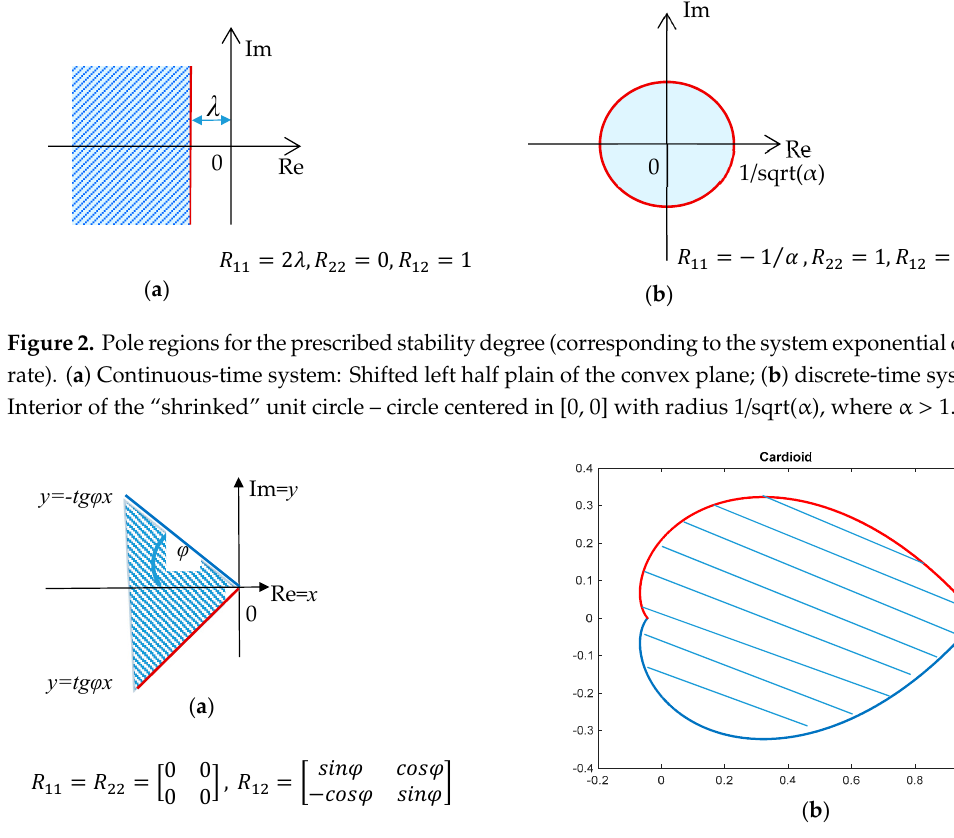
Figure 3. Pole regions for the prescribed relative damping (corresponding to a ratio of the imaginary and real part of the pole). ( a ) Continuous-time system: Interior of the convex cone with vertex angle corresponding to the damping); ( b ) discrete-time systems: The space between two symmetric logarithmic spirals.